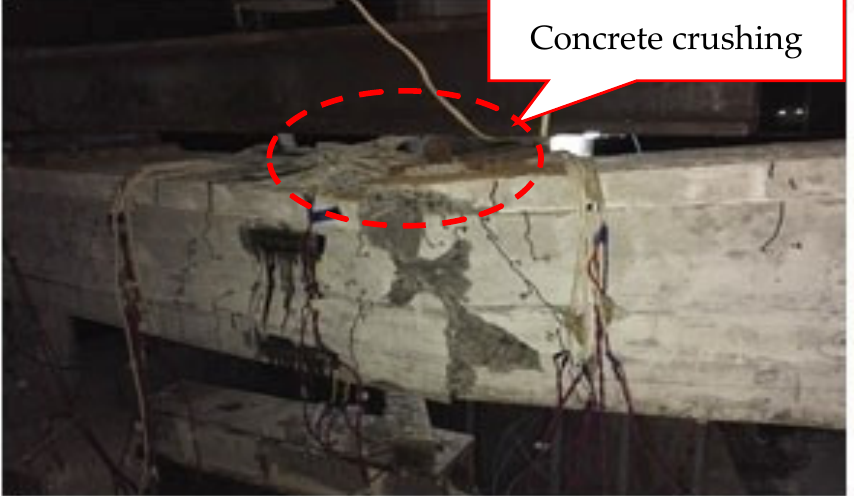
Figure 4. The failure mode of the test beam S1. It should be noted that after the prestressing strands were tensioned, the strain of the prestressing strand in the midspan of the beam is about 4762 µε , the strain of the tensile steel bars at the bottom of the beam is about − 342 µε . Then, the high-pressure grouting pump is used to grout and seal from the reserved grouting port. Due to the reasons for construction, some strain gauges of steel bar and prestressing strand were damaged before or at the beginning of the test. Therefore, in the result analysis, the undamaged strain data in the flexural segment were selected as far as possible. The strain of the concrete compression zone was given by strain gauge 1 illustrated in Figure 1. In the midspan of the beam, the strain of the prestressed steel strand was given by the outermost prestressed steel strand and the strain of the steel bar was given by the outermost tensile steel bar at the bottom. The influence of effective prestress and weight of the test beam was not considered before static loading, and the initial strain and the initial displacement were zeroed. It can be seen from the figure and the test phenomenon that after the concrete at beam bottom cracked, the increase rate of strain and midspan displacement of the test beam all increased significantly. When the applied load was 300 kN, the strain of the tensile steel bar changed abruptly; when the applied load reached 324 kN, the concrete in the compression zone was